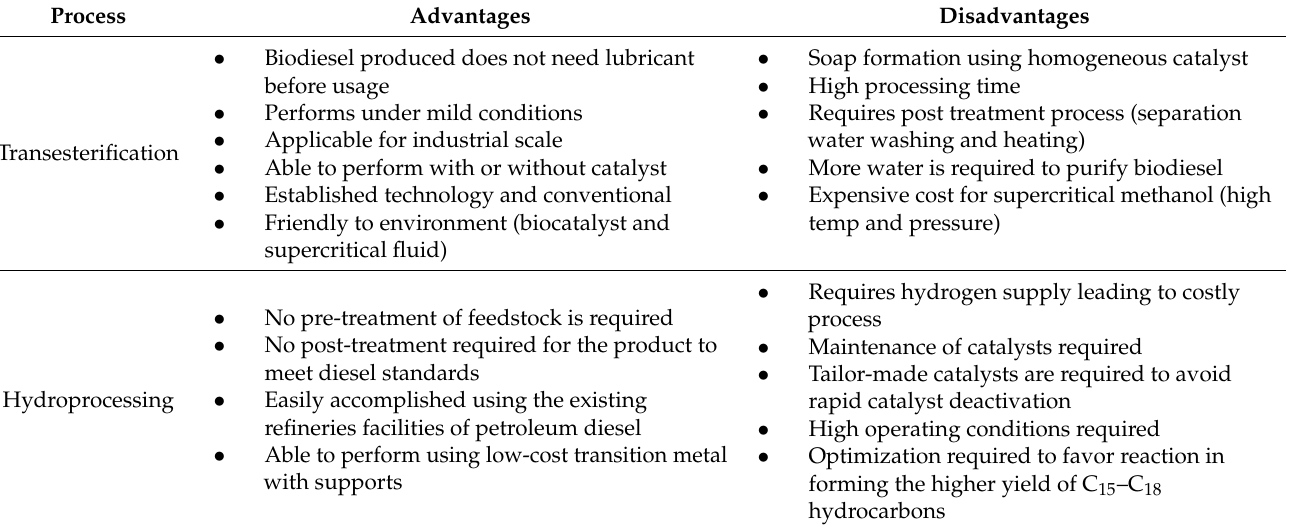
Table 1. Advantages and disadvantages of transesterification and hydroprocessing for biodiesel and renewable diesel production as compared to other techniques